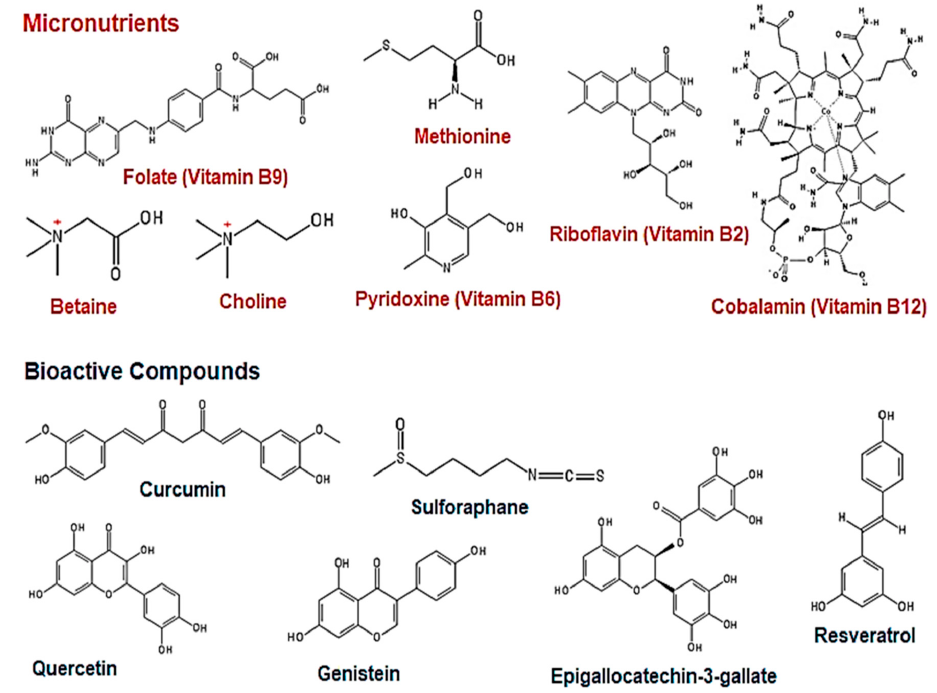
Figure 2. Chemical structures of micronutrients and bioactive dietary compounds. Chemical structures were drawn using PubChem Sketcher Version 2.4.